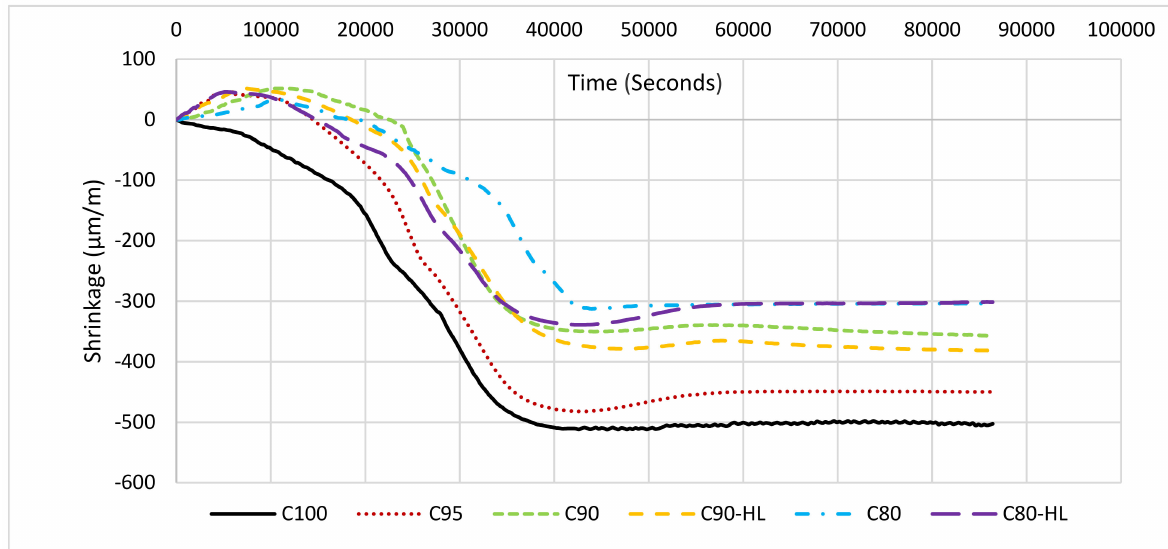
Figure 10. Self-compacting paste formulation shrinkage at the various percentages of waste burnt brick